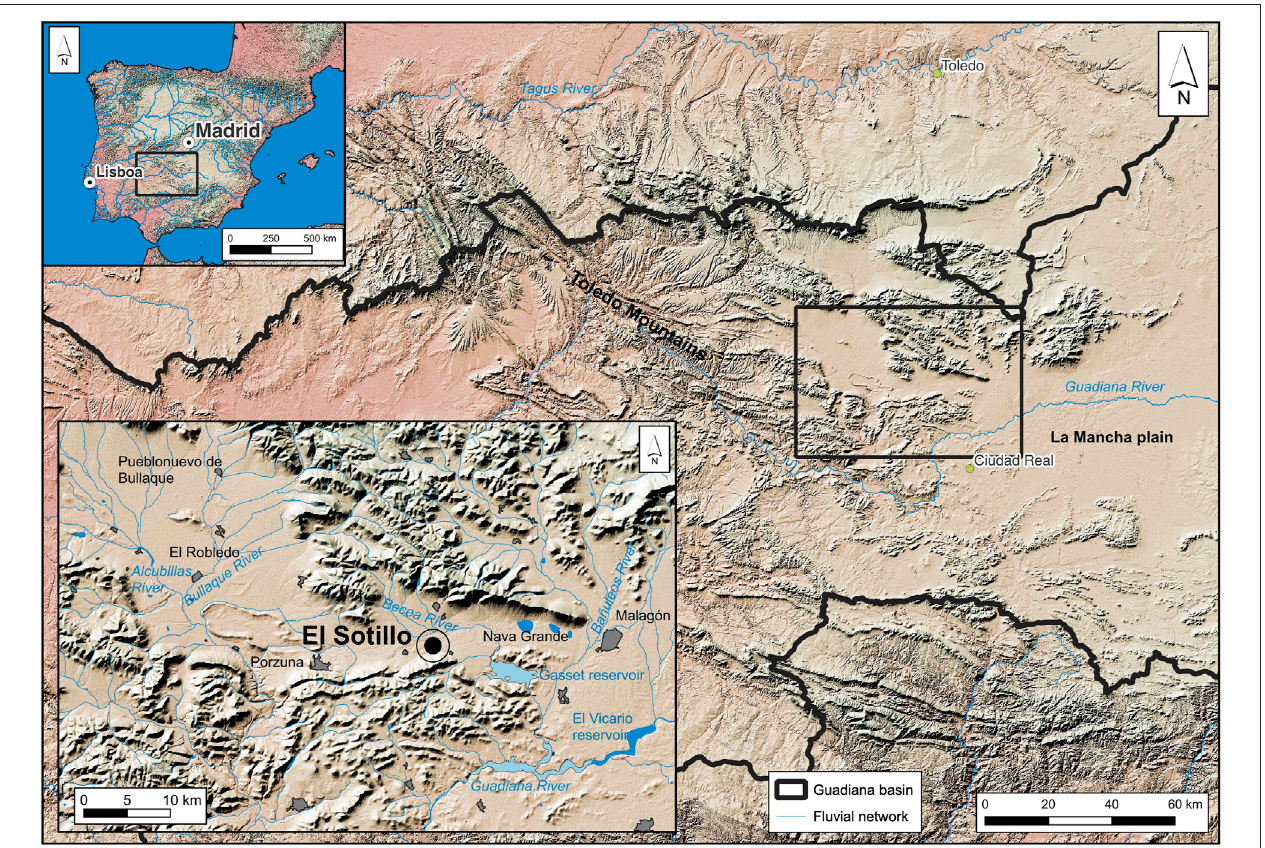
FIGURE 1 | Location of El Sotillo in the central-southwestern area of the Iberian Peninsula, and in the south-eastern sector of Montes de Toledo. In the bottom-left inset, the Acheulean site of El Sotillo is framed to the north and south by Palaeozoic hills with quartzite rocks, in the Porzuna-Malagón depression. Map made with data layers provided by the